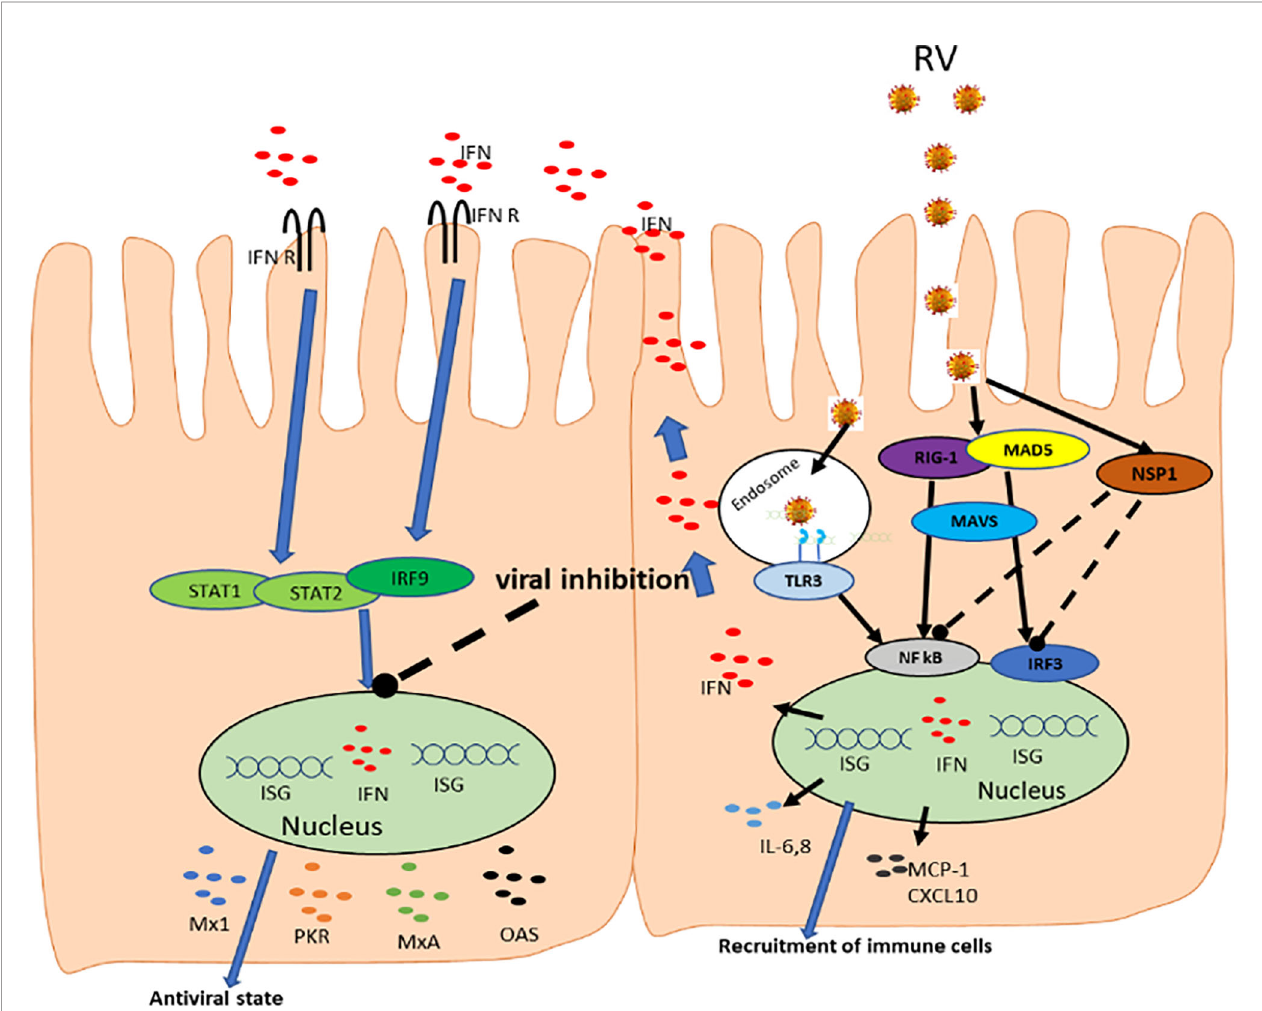
FIGURE 2 | Rotavirus interactions with host innate immune system. RV enters cells, where it is recognized by RIG-I and MDA-5 receptors triggering the transcription factors IRF3 and NF-kB through signaling facilitated by MAVS. The activated IRF3 and NF-kB moves to the nucleus and upregulate the expression of type I and III IFNs which stimulates the synthesis of IFN stimulatory genes. Activation of NF- k B pathway by PRRs results in the production of proin fl ammatory cytokines and chemokines such as IL-6, IL-8, MCP-1, CXCL10. The IRF3 and NF-kB are degraded through interaction with viral NSP1. IFNs are then released and binds their receptors leading to activation of STAT-1, STAT-2, and IRF9 which further promote IFN production and creating ‘ antiviral state ’